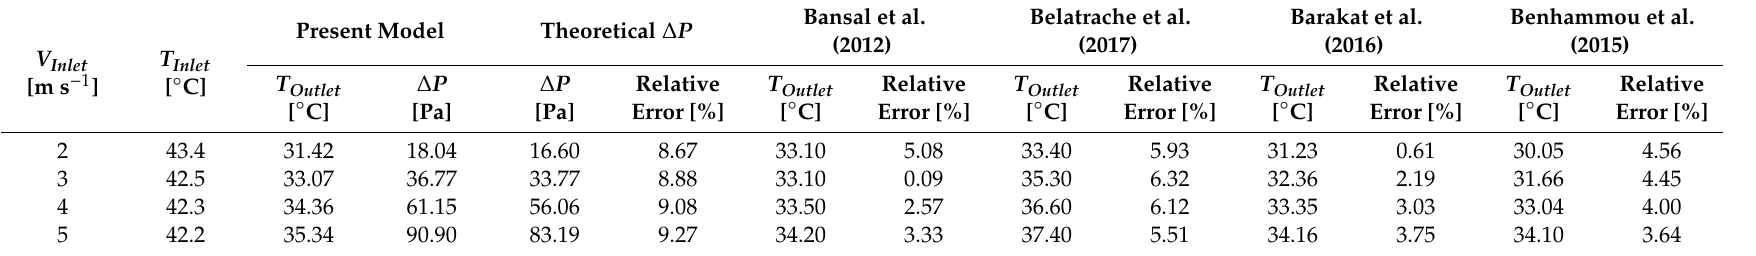
Table 3. Results of model validation